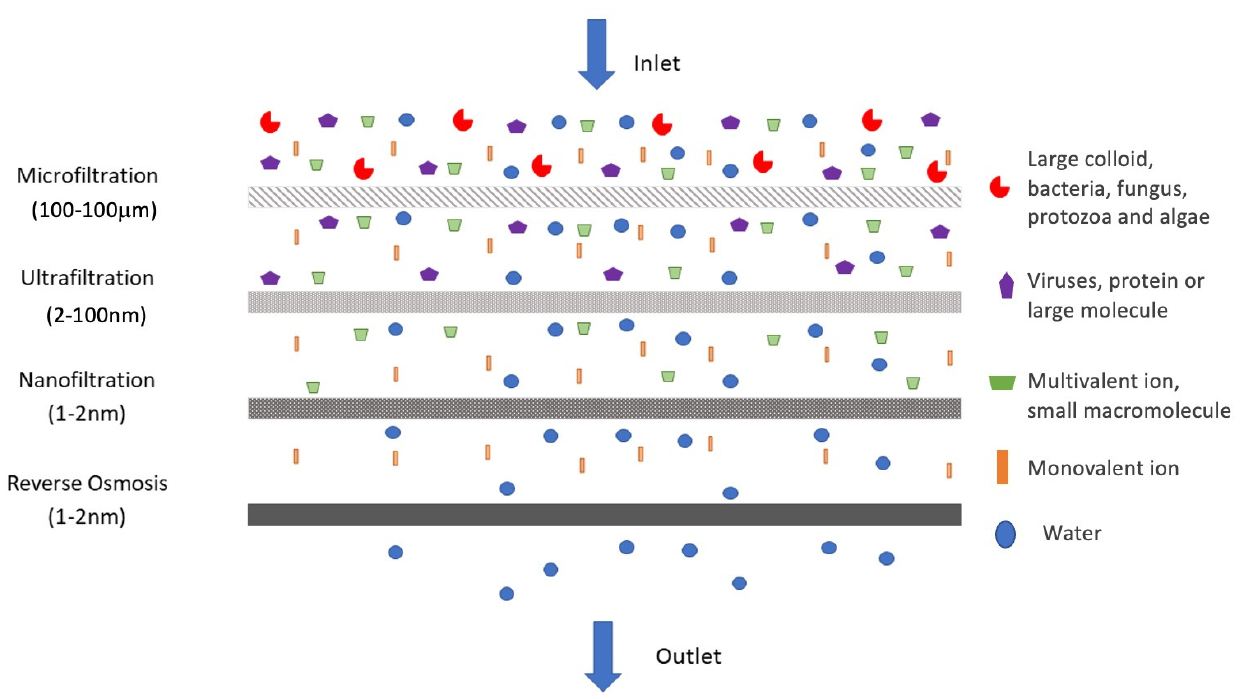
Figure 2. Comparison of the size and type of contaminants rejected by membrane filtration techniques. Table 2. Representative studies on the properties of CNF films from different raw